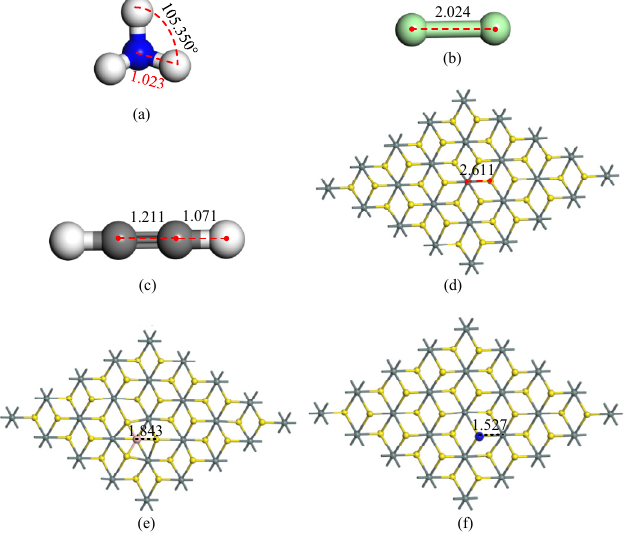
Figure 1. The optimized structures: ( a ) NH 3 , ( b ) Cl 2 , ( c ) C 2 H 2 , ( d ) SnS 2 , ( e ) B-SnS 2 surface, ( f ) N-SnS 2 surface. The distance is Å.